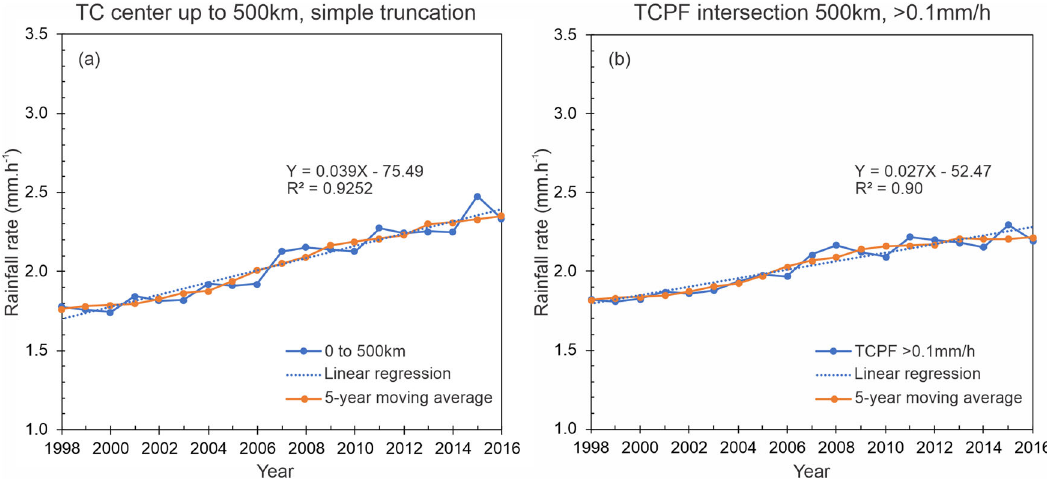
Fig. 1 Time series and the linear regression fi t of TC rain averaged within the total TC rainfall area for TCs in all global TC-prone basins during 1998- 2016. The total TC rainfall area is de fi ned by. a Simple truncation method, and b tropical cyclone precipitating feature method. The linear fi tting function and square of the correlation are indicated. The 5-year moving average is also